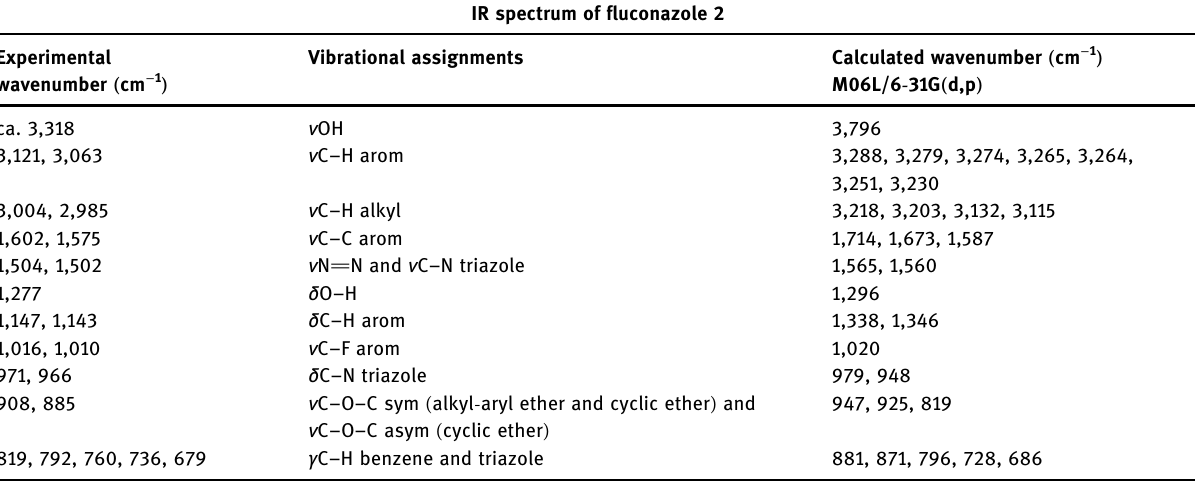
Table 4: IR spectrum of compound 2 ; M06L/6 - 31G ( d,p ) //M06L/6 - 31G ( d,p ) /gas level of theory IR spectrum of fl uconazole